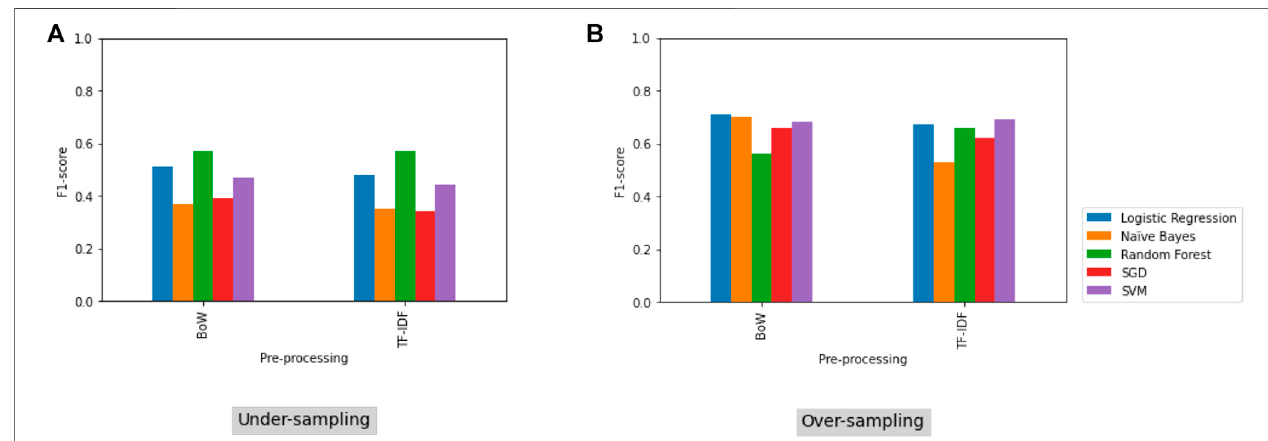
FIGURE7| Comparisonofclassi fi cationoftheF 1 scoremetricforthemodelsobtainedbythetwofeatureextractionmethods(BoWandTF-IDF)forunder-sampled (A) and over-sampled (B) data. The F 1 score is used in the case of imbalanced datasets.